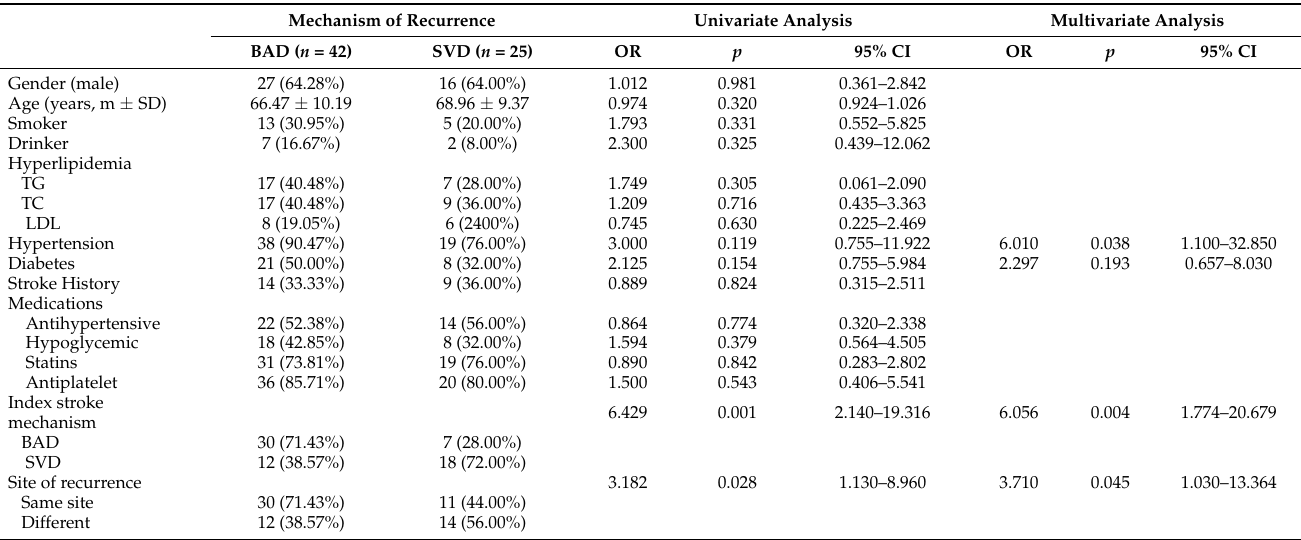
Table 2. Mechanism of recurrence.